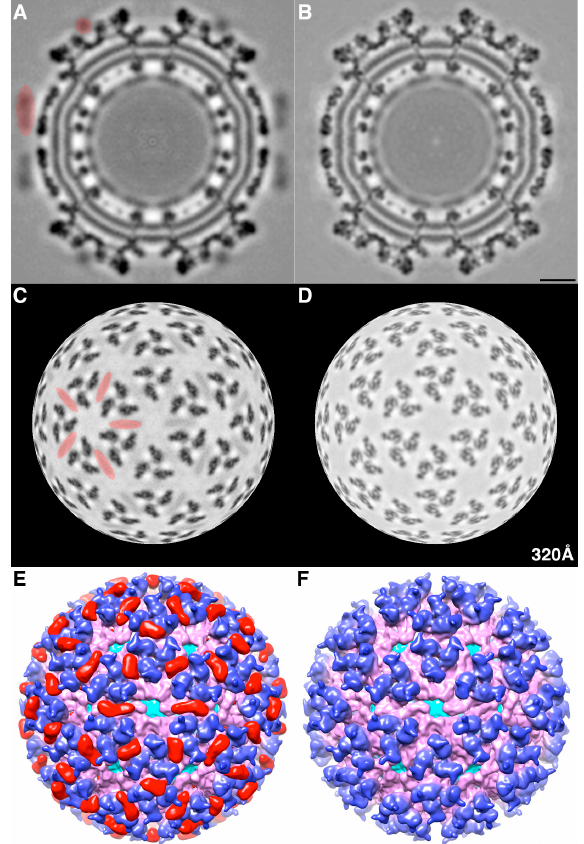
Figure 3. Comparison of mCherry ‐ E2 and WT virus cryoEM structures: ( A ) Central section of mCherry ‐ E2 virus showing extra densities marked in red compared to WT virus; ( B ) Radial projection views at radius of 320 Å show extra densities on the surface of the mCherry ‐ E2 virus (Panel C , highlighted in red) compared to WT virus ( D ). Surface view, color ‐ cued by radius (from cyan to pink to blue with increasing radius) of the mCherry ‐ E2 virus ( E ) reveals extra densities (colored in red) compared to the WT virus ( F ). The scale bars represent 100 Å.